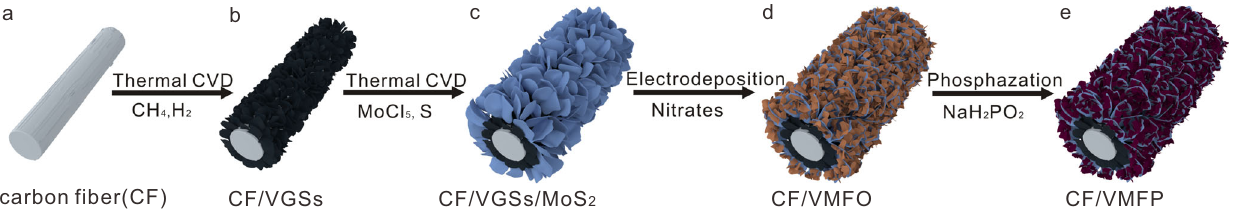
Fig. 1 A schematic diagram showing preparation process of samples. a – d Preparation procedure of CF/VMFO. e Preparation procedure of CF/VMFP from